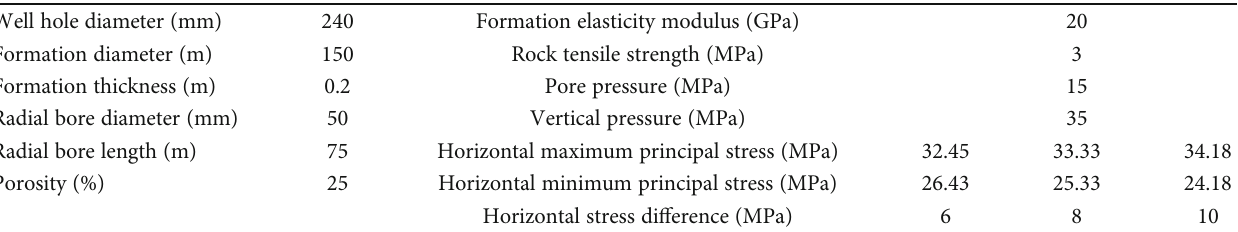
Figure 2: Comparison of simulation results and experiment results. Table 2: Table of basic model